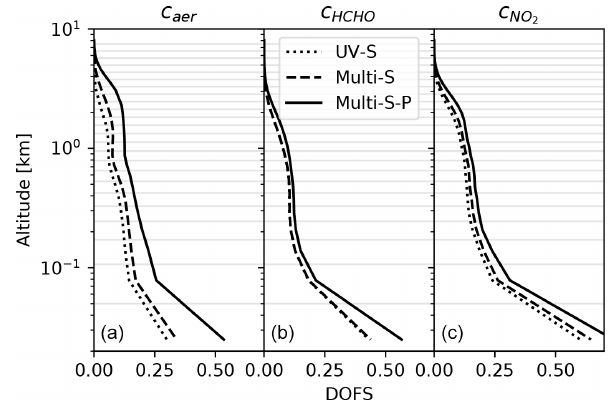
Figure 5. Average DOFS vertical profiles for aerosol (a) , HCHO (b) , and NO 2 (c) concentrations. Different measurement modes were simulated as indicated in the legend. Horizontal grey lines indicate model-layer